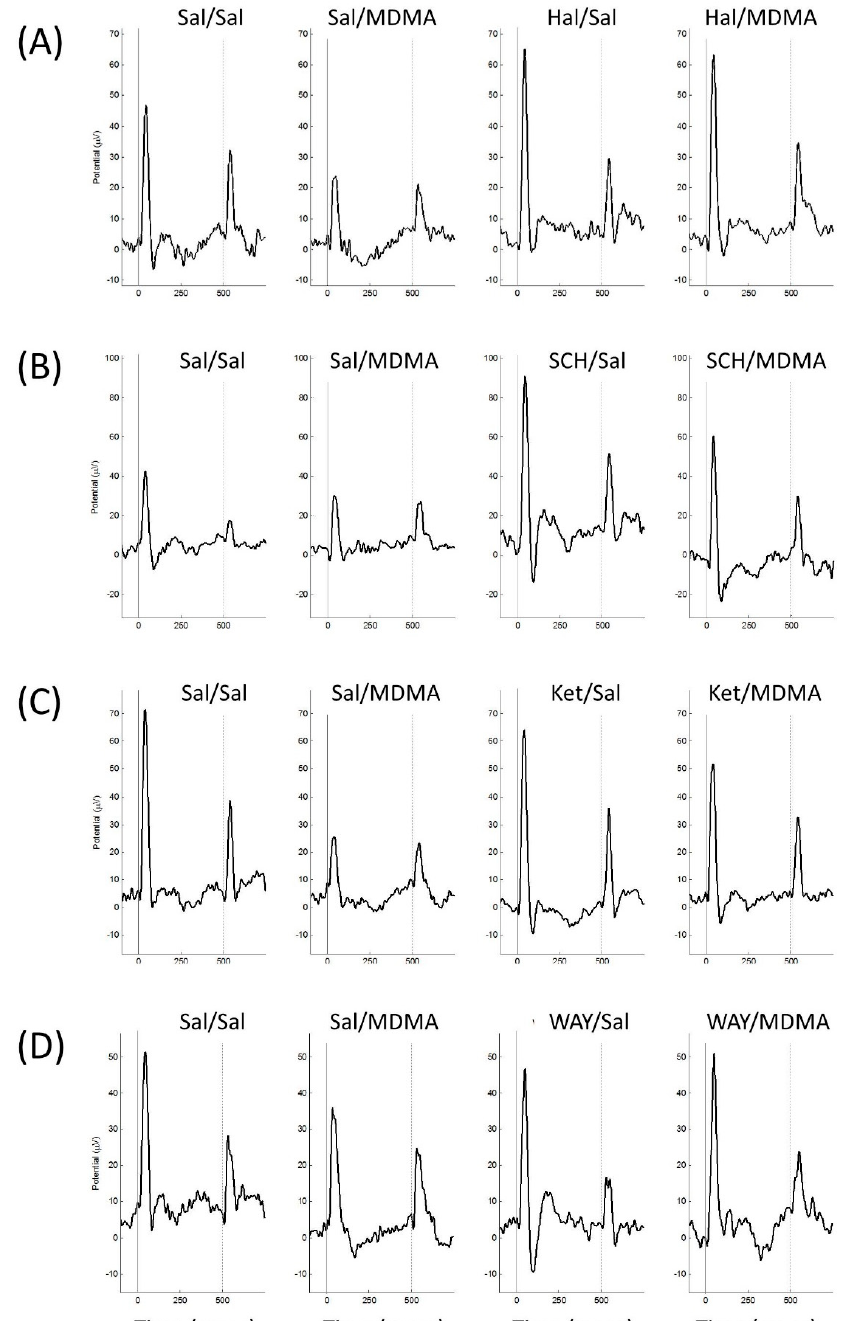
Figure 1. Grand-average waveforms for each MDMA cohort and condition. Clear event-related potentials (ERP) from the two clicks, indicated by the grey vertical lines, were elicited for each cohort in each condition. ( A ) shows the grand-average waveform for the haloperidol (Hal) cohort. ( B ) displays the grand-average waveforms for the SCH23390 (SCH) cohort. ( C ) shows the grand-average waveforms for the ketanserin (Ket) cohort. ( D ) displays the grand-average waveforms for the WAY100635 (WAY)